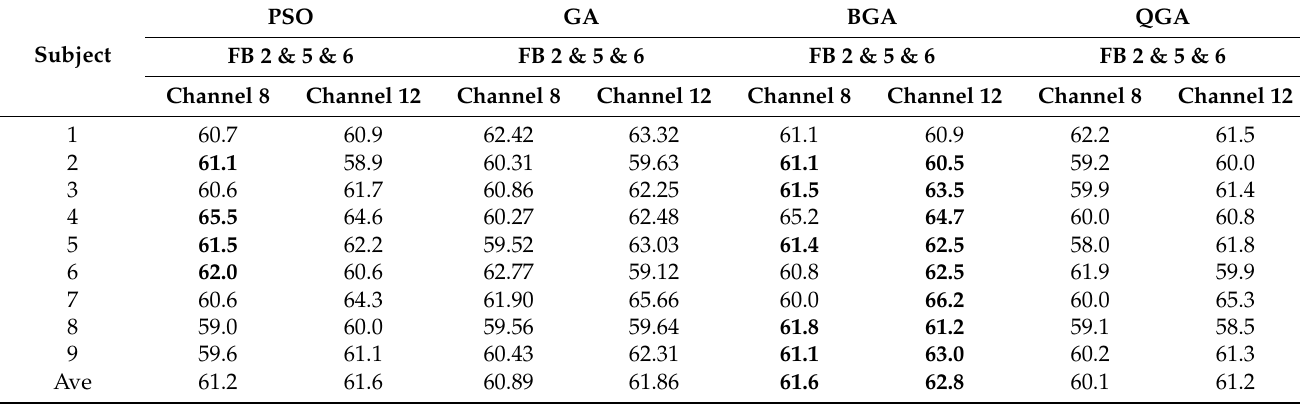
Table 10. Feature selection accuracy of PSO, GA, and BGA with 100 features, FB2 & 5 & 6, and ELM for 100